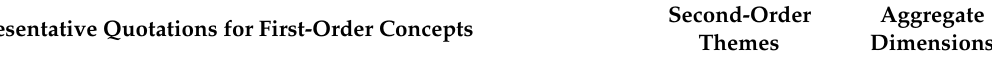
Table 5. Data Structure in the Growth Stage